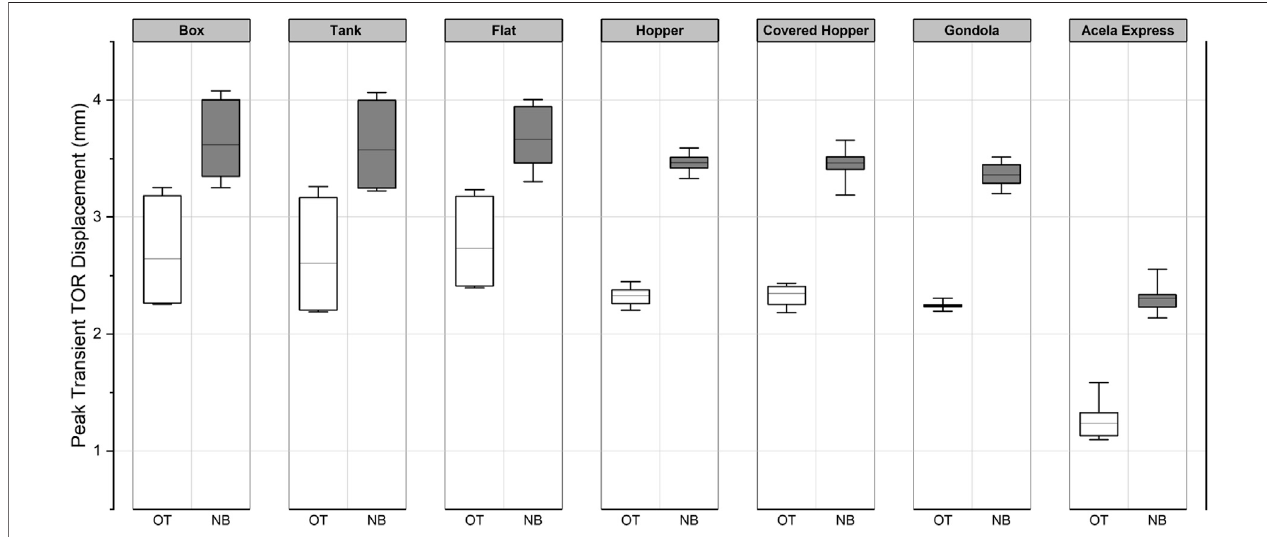
FIGURE 9 | Comparison of peak rail vertical displacement with passenger train passage and freight trains passage on shared track rail corridor.